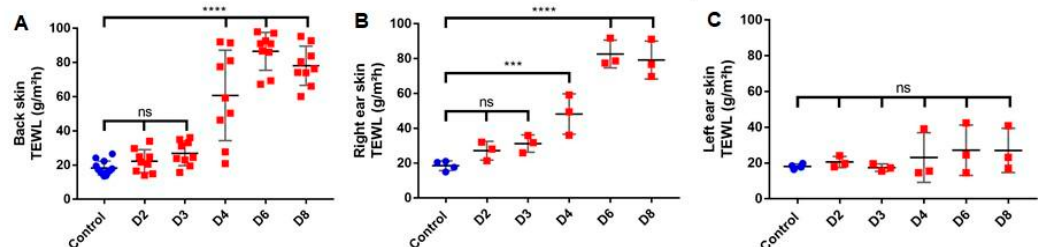
Figure 6. TEWL evaluation during IMQ induction of psoriasis-like dermatitis. TEWL was measured thrice at 3 spots for each mouse back (3 times on the left flank, 3 times on the right flank and 3 times on the upper back) ( n = 3, except for control where n = 4) ( A ). TEWL was also measured on both ears, right ear with IMQ treatment ( B ) and left ear as control ( C ) ( n = 3, except for control where n = 4). Results were statistically analyzed using one-way ANOVA followed by Dunnett’s multiple comparison test. Values are presented as mean ± SD. ***: p < 0.0005, ****: p < 0.0001.